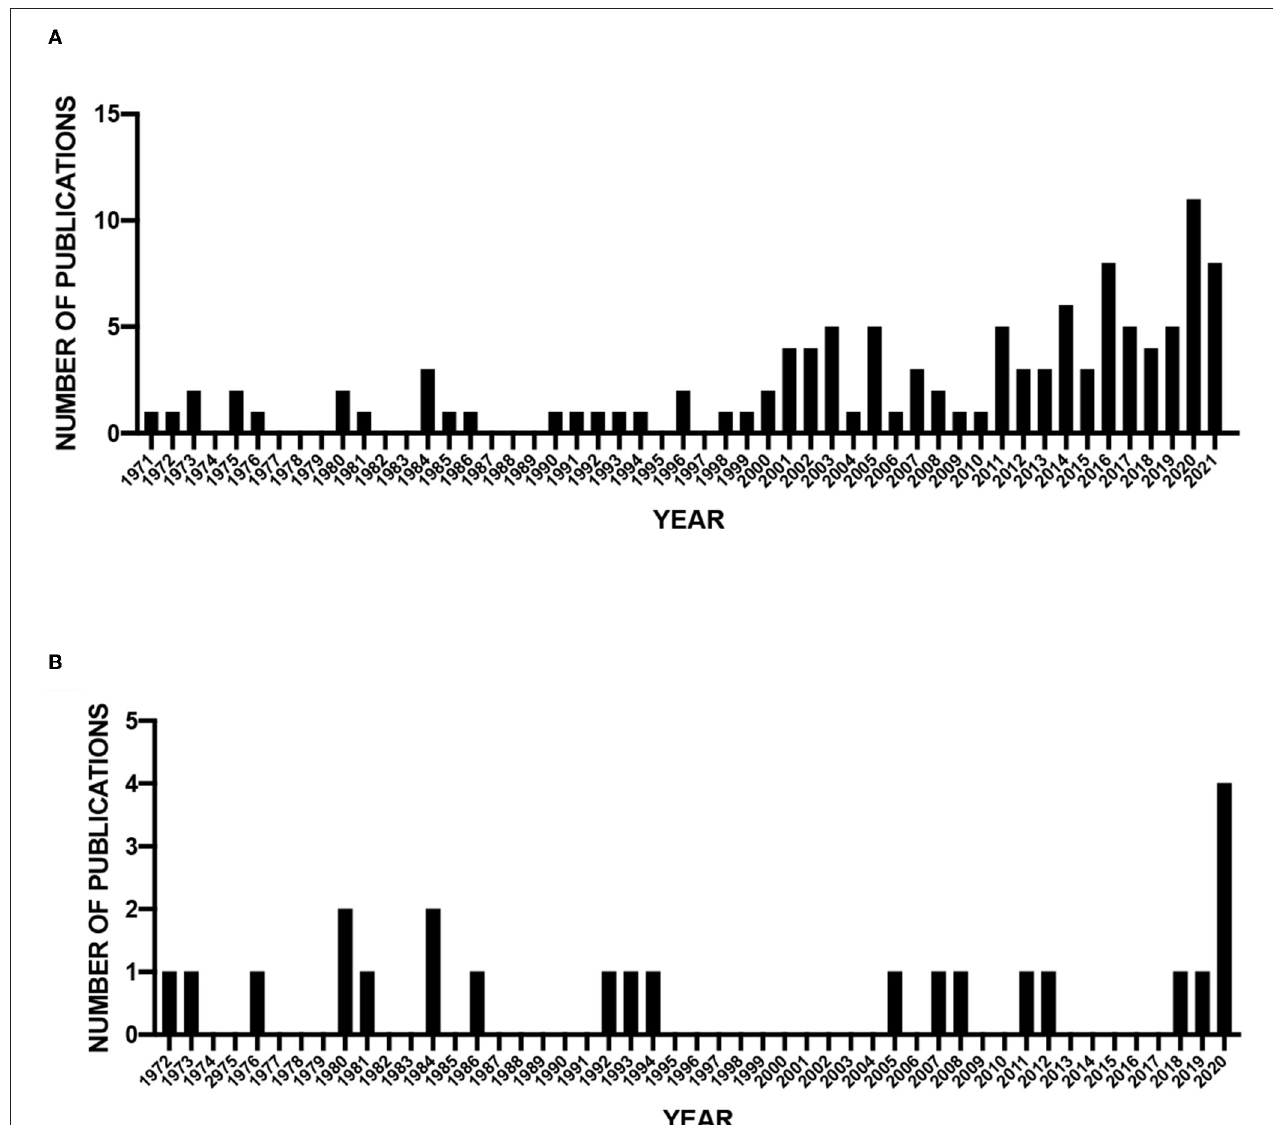
( Figure 1 ). Historical or non-indexed publications not